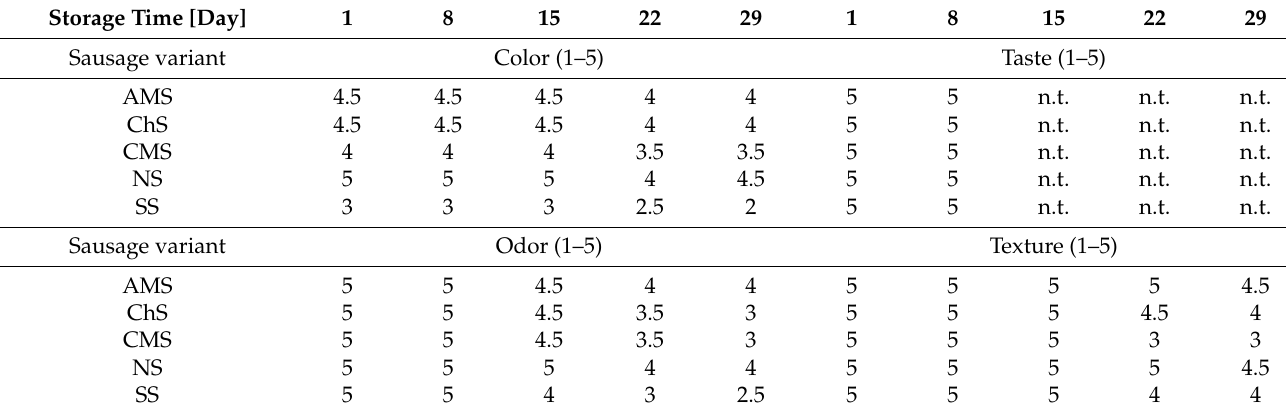
Table 3. Effect of Aronia melanocarpa, Chaenomeles superba , and Cornus mas leaf extracts on the sensory properties of pork sausages stored in MAP at 4 ◦